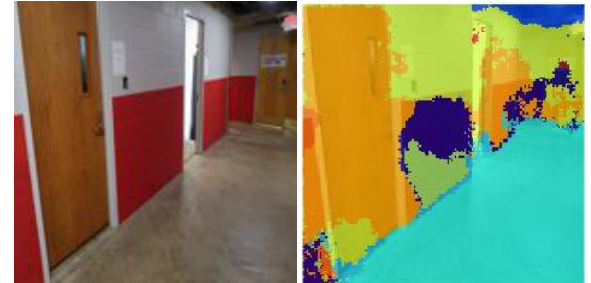
Figure 9. Exemplary results of labelling the indoor